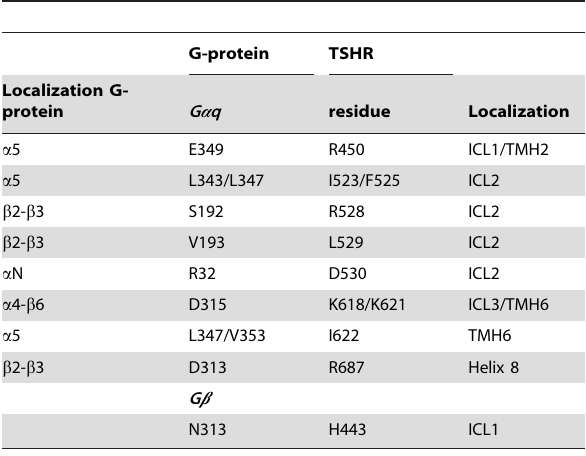
Table 3. Potential direct intermolecular interaction partners between TSHR and Gq.